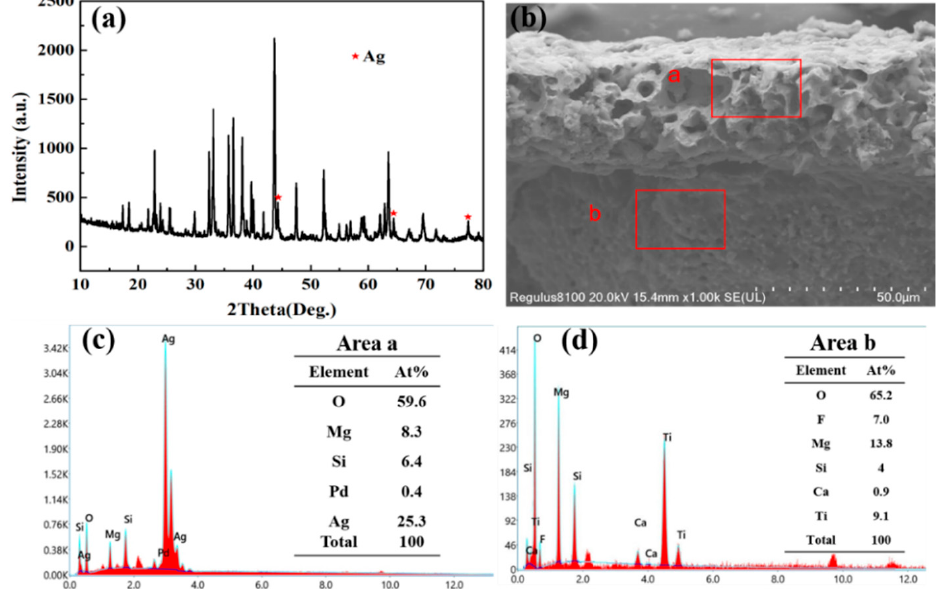
Figure 6. ( a ) XRD pattern of MLLC11.5-40 wt% Ag powders calcined at 800 °C, ( b ) SEM micrograph of the cross-section of MLLC11.5 ceramic coated with silver slurry and sintered at 800 °C, ( c ) EDS result of area a, and ( d ) EDS result of area b.